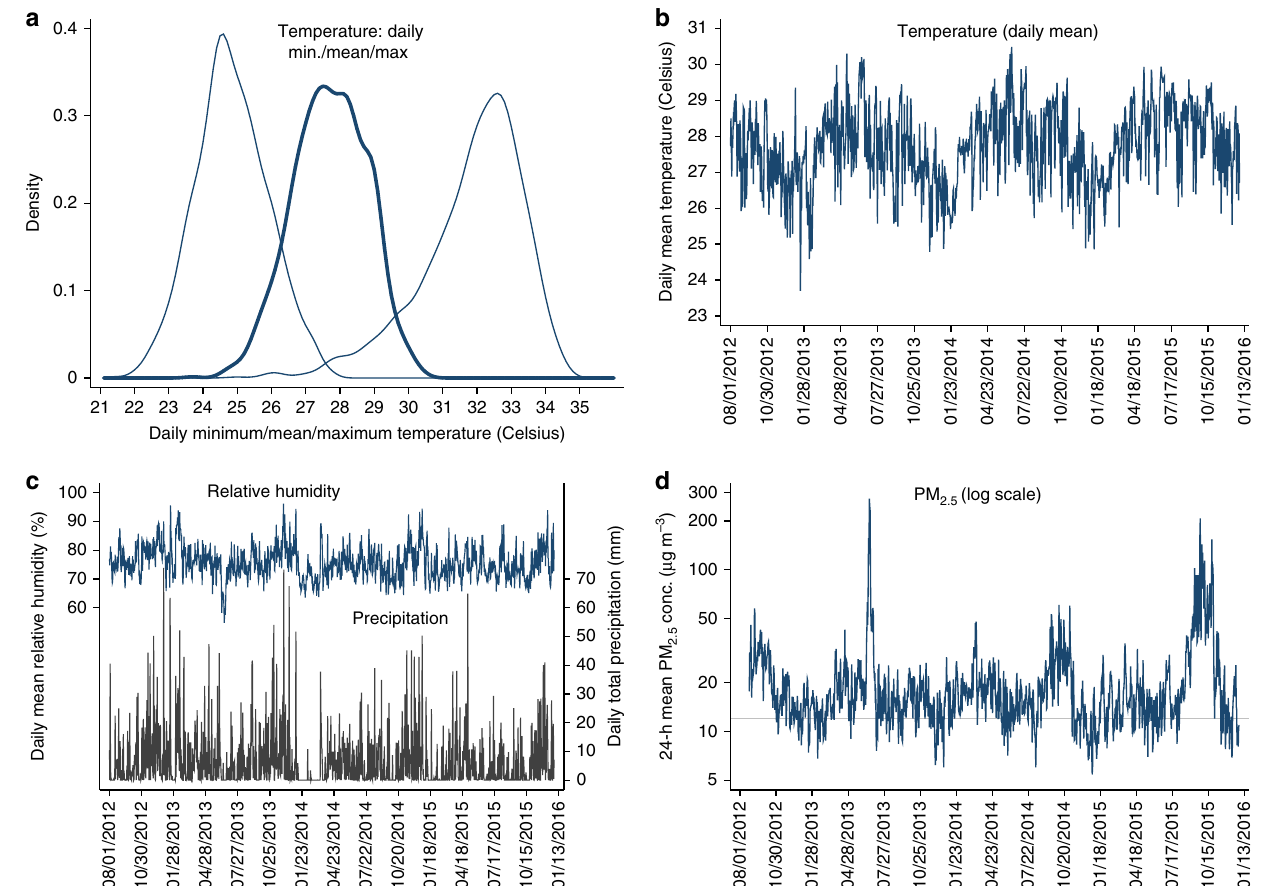
Fig. 2 Ambient environmental conditions from 2012 to 2015. a Distribution of daily minimum, daily mean, and daily maximum temperature (°C). b – d Evolution of daily mean temperature (°C), daily mean relative humidity (%) and daily total precipitation (mm), and daily mean PM 2.5 mass concentrations ( µ g m − 3 , in log scale), respectively. The sample period is August 1, 2012 (August 24, 2012 for PM 2.5 ) to December 31, 2015. An observation is a day. The horizontal line in d marks both the US EPA ’ s primary standard and the Sustainable Singapore Blueprint target. Sources: Meteorological Service Singapore (temperature, precipitation), NUS Geography Weather Station (relative humidity), National Environment Agency (PM 2.5 ). Source data are provided as